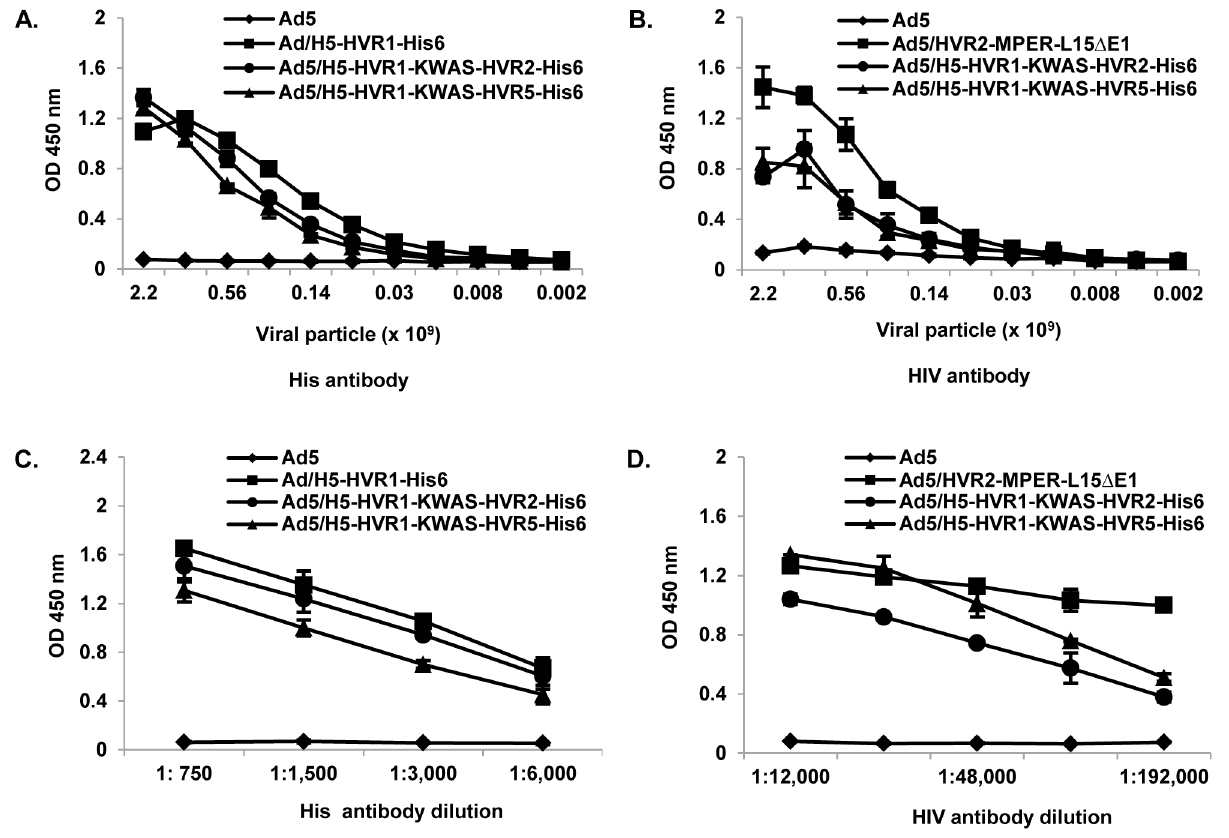
Figure 3. HIV and His 6 epitopes in the HVRs are exposed on the virion surface. A) In the assay, varying amounts of Ad5, Ad/H5-HVR1-His 6 , Ad5/H5-HVR1-KWAS-HVR2-His 6 , or Ad5/H5-HVR1-KWAS-HVR5-His 6 were immobilized in the wells of ELISA plates and incubated with anti-His 6 antibody. The binding was detected with an HRP-conjugated secondary antibody. B) In the assay, varying amounts of Ad5, Ad5/HVR2-MPER-L15 D E1, Ad5/H5-HVR1-KWAS-HVR2-His 6 , or Ad5/H5-HVR1-KWAS-HVR5-His 6 were immobilized in the wells of ELISA plates and incubated with anti-HIV antibody. The binding was detected with an HRP-conjugated secondary antibody. C) In the assay 6 6 10 8 VP of Ad5, Ad/H5-HVR1-His 6 ,